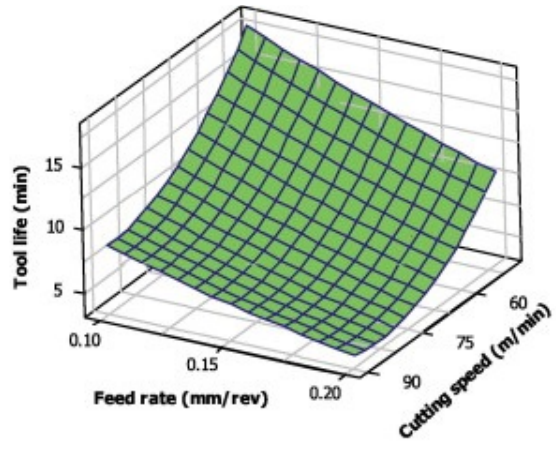
Figure 6: Effects of cutting speed and feed rate on tool life [36]